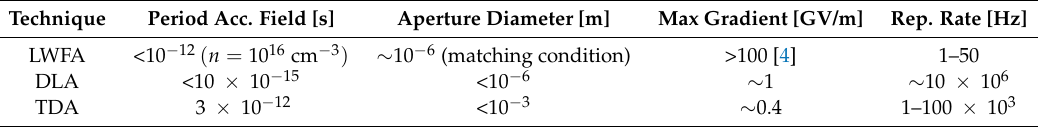
Table 1. Overview of the order of magnitude of typical beam and field parameters for several laser-driven novel acceleration techniques. The listed repetition rates are typical values mainly limited by the lasers and they are not fundamental limitations of the acceleration method.